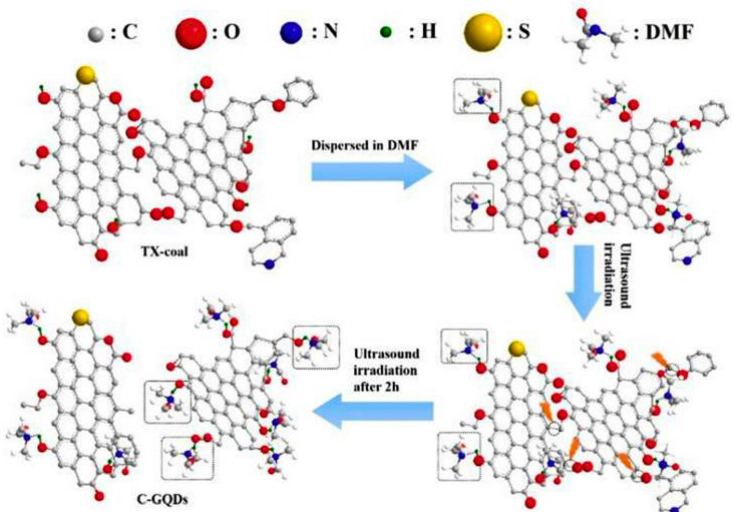
Figure 6. Schematic illustrating the generation of C-GQDs from coal precursors. Reprinted with permission from Ref. [79], Copyright (2019) American Chemical Society. The TaiXi anthracite coal (TXcoal) precursor was homogeneously dispersed in N , N -dimethylformamide (DMF) to rapidly form hydrogen bonds between DMF and the oxygen-containing groups of the coal molecules. Following that, the suspension was ultrasonicated in an ultrasonic cell crusher, and acoustic cavitation caused high pressure (in excess of 500 bar), intense local heating (5000 ◦ C), and cooling rates greater than 1010 K s − 1